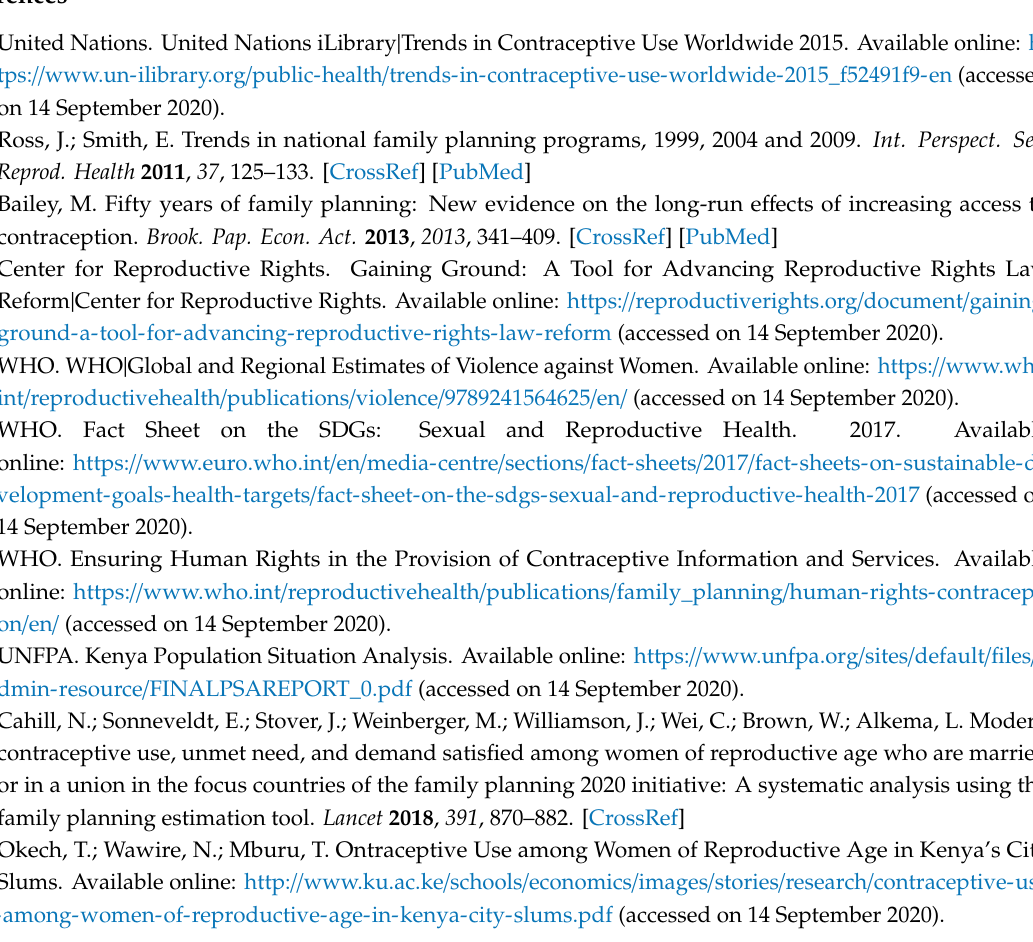
Figure S1: Contraceptive use by type of residence, Figure S2: Contraceptive use by women’s education, Figure S3: Contraceptive use by husband’s education, Figure S4: Contraceptive use by number of living children, Figure S5: Contraceptive use by working status, Figure S6: Contraceptive use by age at first marriage, Figure S7: Contraceptive use by marital status, Figure S8: Contraceptive use by age